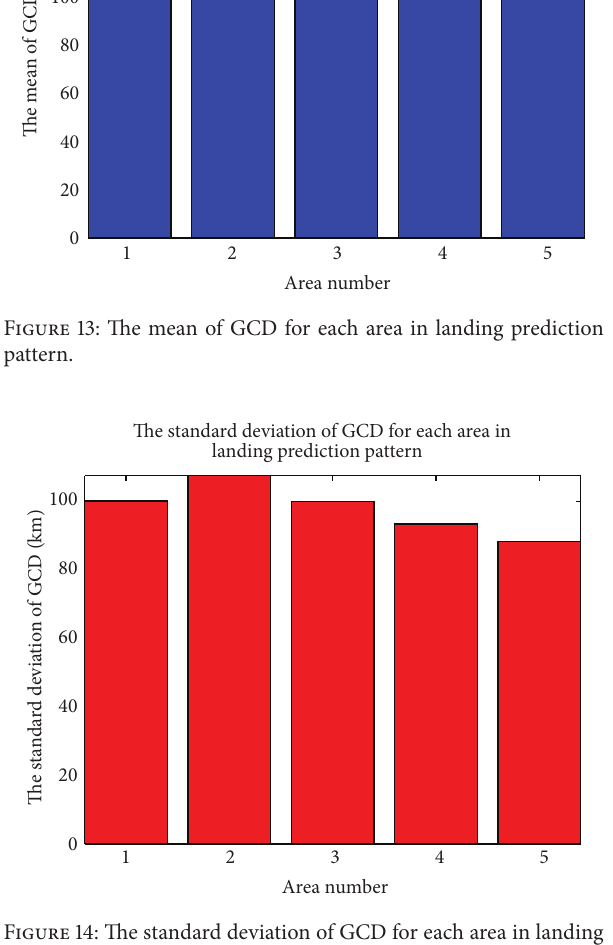
Figure 14: The standard deviation of GCD for each area in landing prediction